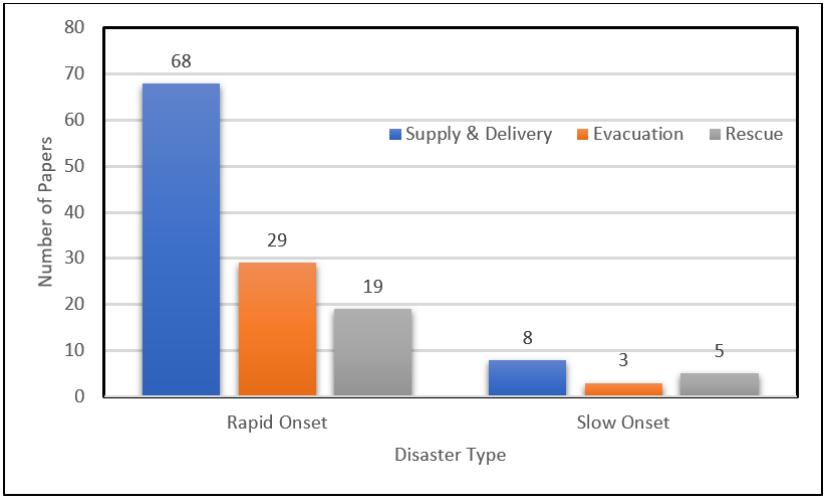
Figure 10. Selected Humanitarian Operation based on Disaster Type.